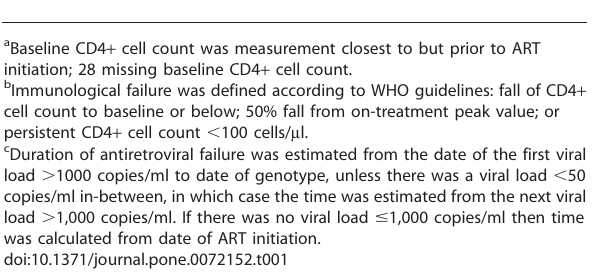
Table 1. Demographic and clinical